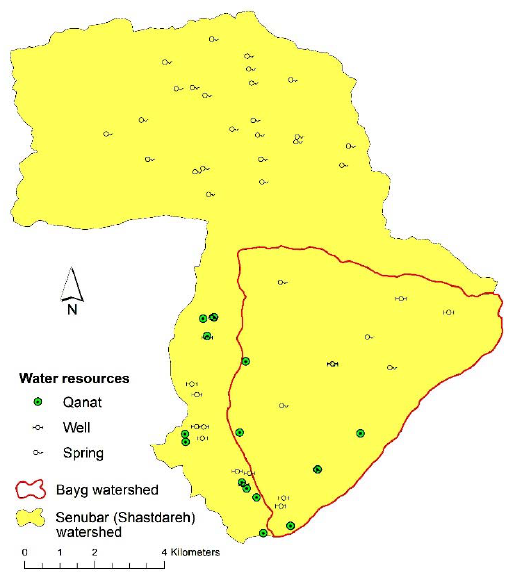
Fig. 7: (a) Runoff yield, (b) sediment load, and (c) net income, in each land use before and after optimization Fig. 6: Available water resources in the study area